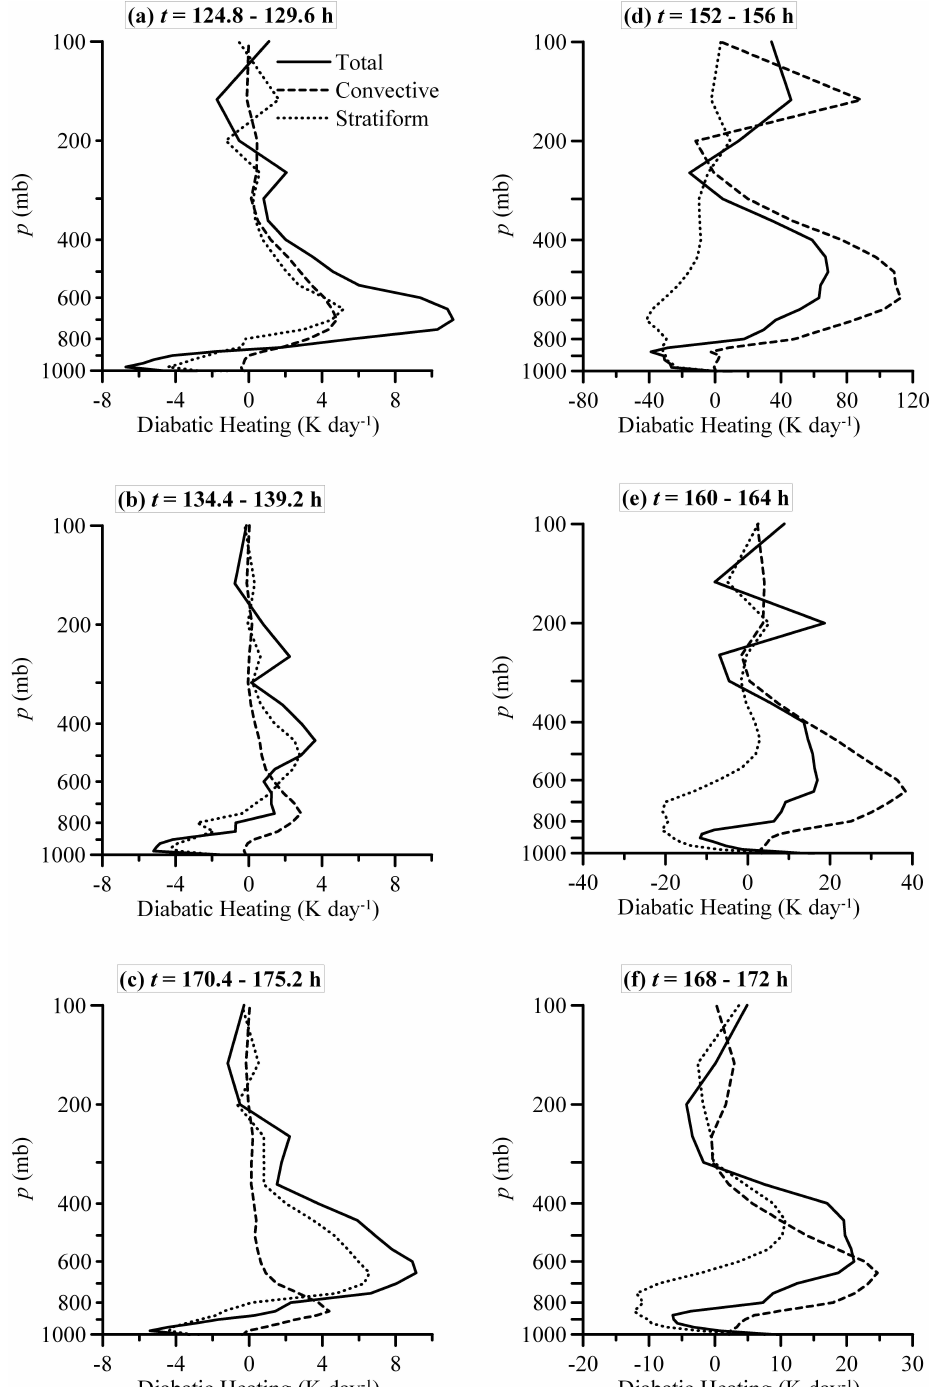
Fig. 5. Area-averaged diabatic heating, showing contributions from convective and stratiform precipitation regions in the control simulation, for a box surrounding the vortex on the 3.3-km grid, at simulation time: (a) 124.8h to 129.6h; (b) 134.4h to 139.2h; and (c) 170.h to 175.2h, and for the CAPE simulation at (d) 152h to 156h; (e) 160 h to 164h; and (f) 168h to 172h. The area average heating rate pertains to the analysis box, which is centered on the area of the circulation and has its southern edge roughly along the line of maximum rear inflow into the